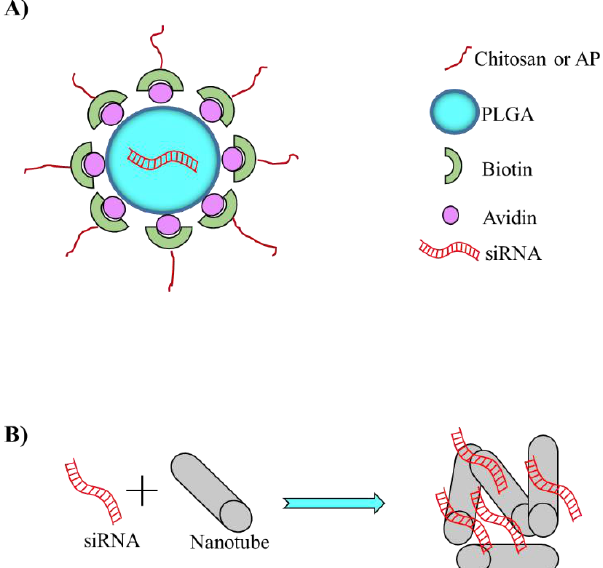
Figure 4. ( A ) PLGA nanoparticles were modified by the addition of either chitosan or penetratin (AP) via biotin-avidin link, from [72]. ( B ) Fe-doped chrysotile nanotubes were developed to carry and deliver siRNA, from [76]. deliver siRNA, from